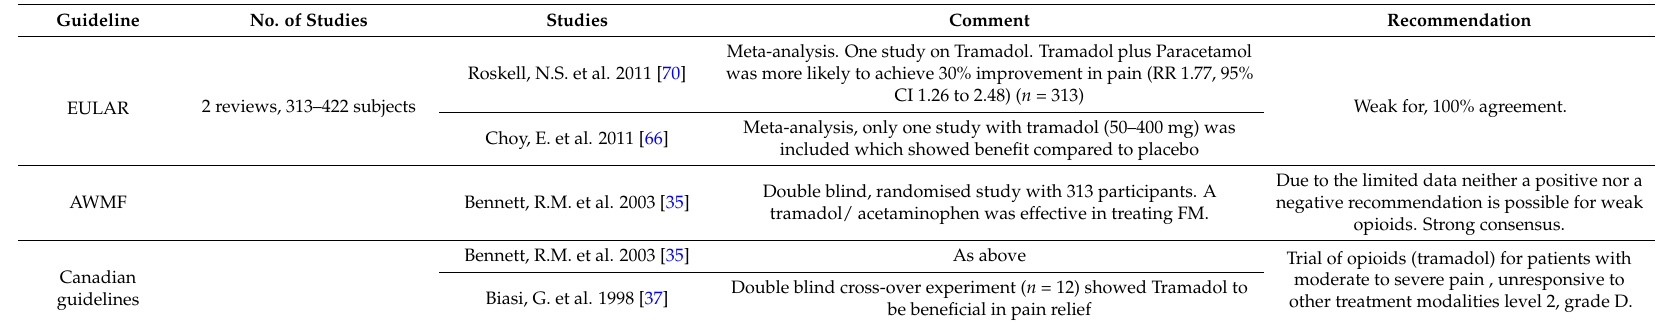
Table A6. Tramadol.